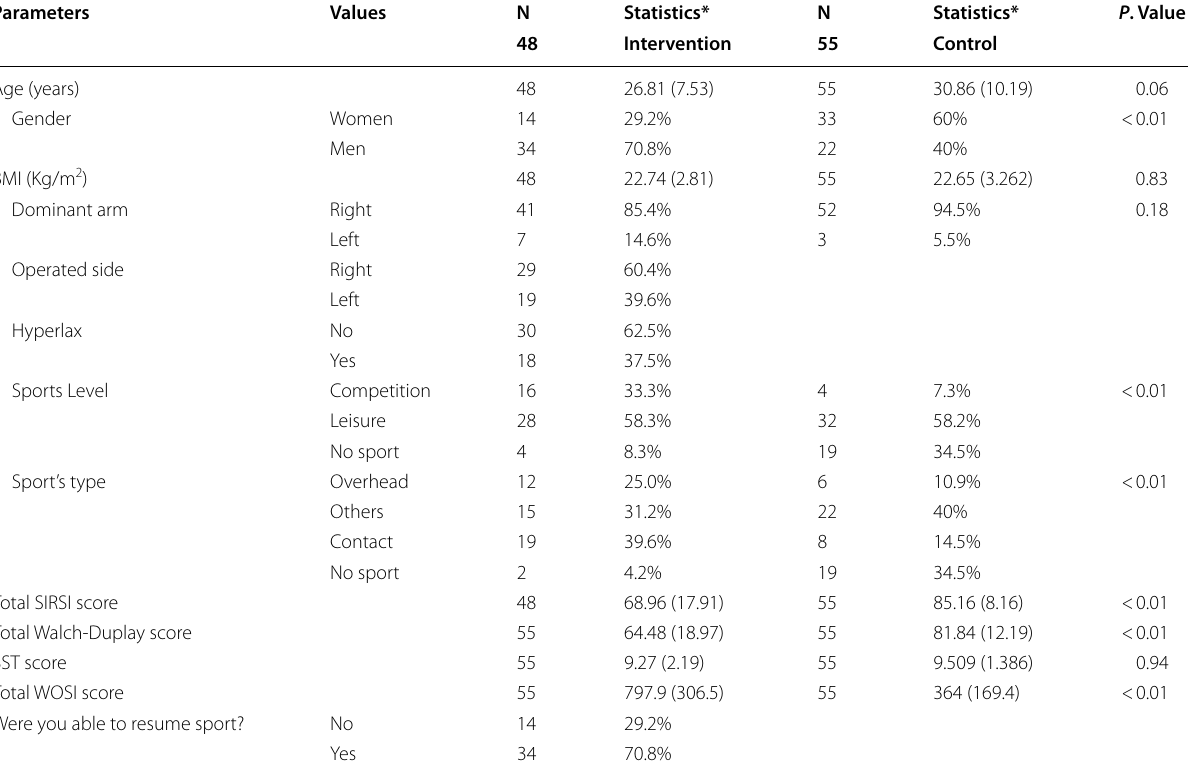
Table 1 Participants vs control